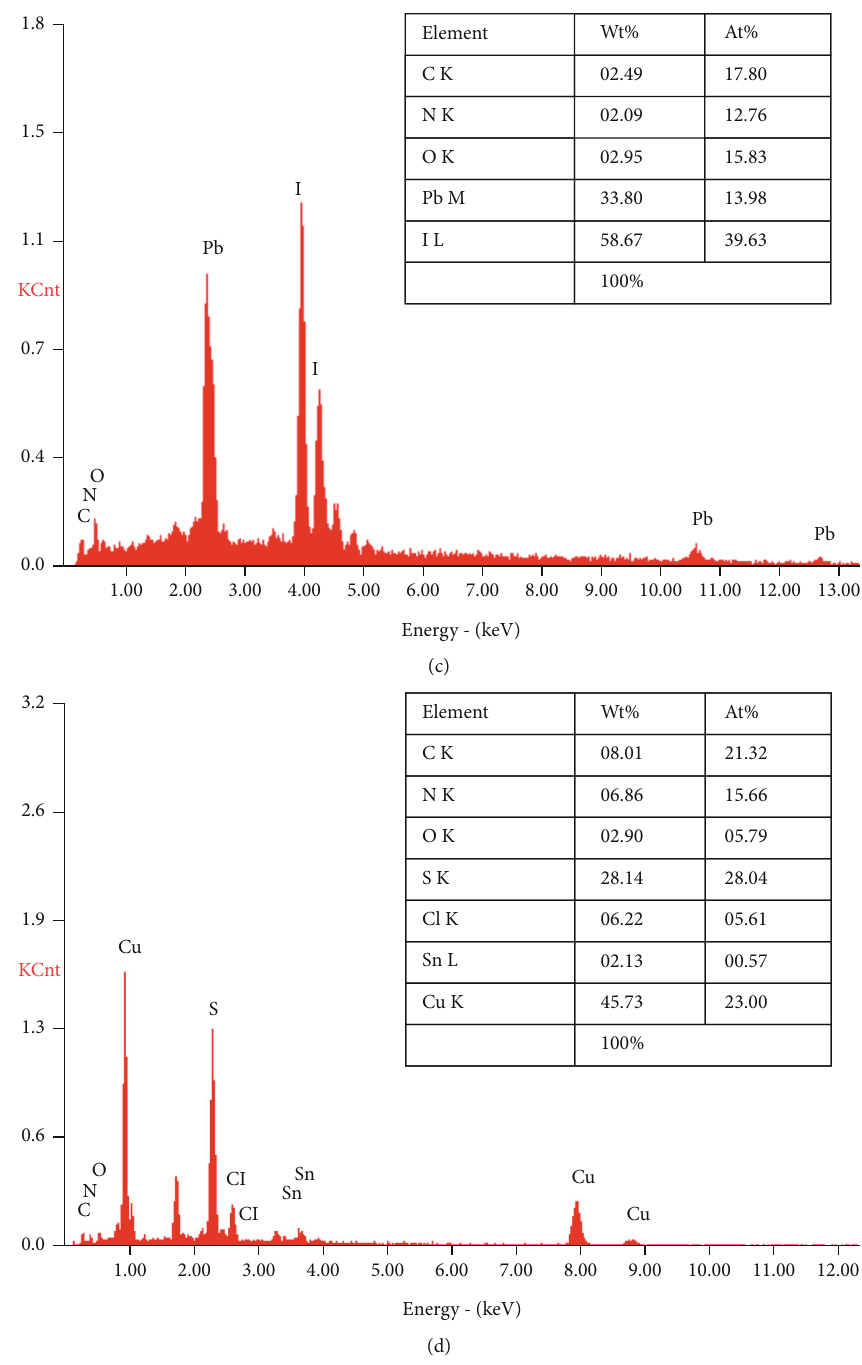
Figure 4: EDX analysis of (a) TiO